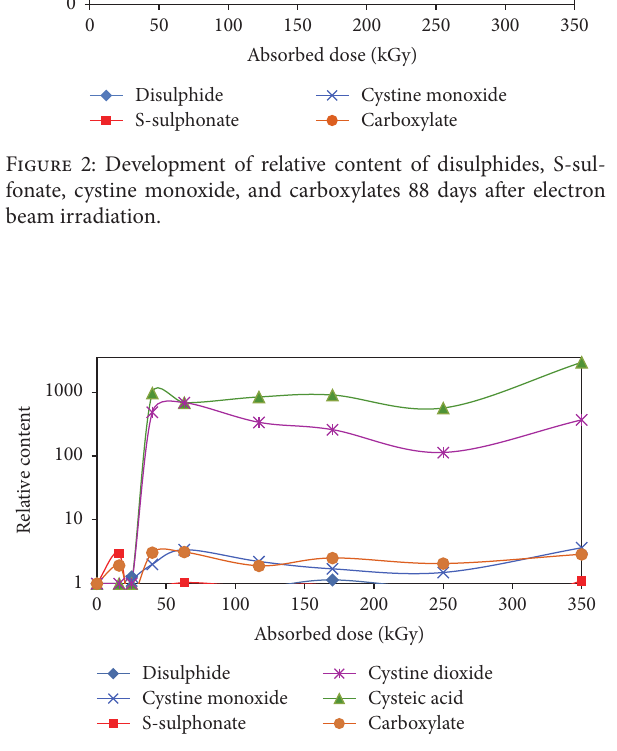
Figure 3: Development of relative content of cystine dioxide and cysteic acid along other species in the wool with absorbed dose 88 days after electron beam